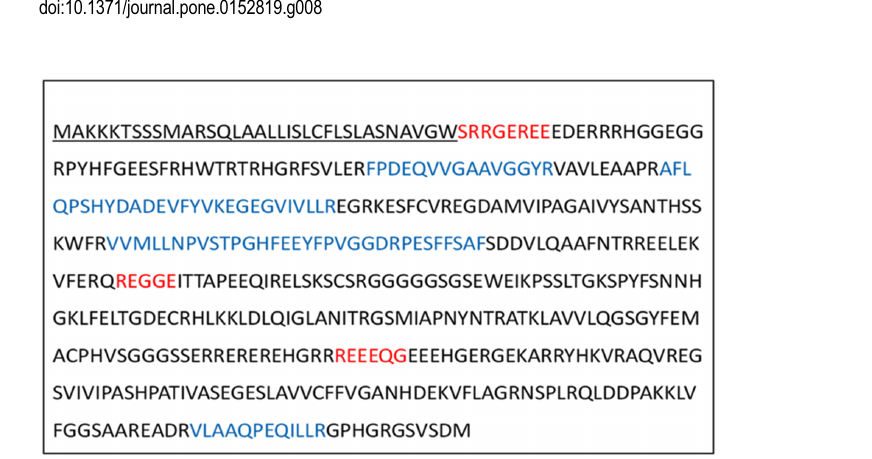
Fig 9. Deduced amino acid sequence of cupincin. The putative signal sequence is underlined (S6 Fig). Amino terminal sequence as determined by Edman degradation method is indicated in red. Peptide sequences obtained by in-gel trypsin digestion and MS/MS analysis are indicated in blue (S8A – S8G Figs). OsI_13867 (NCBI) or LOC Os06g43830.1 (TIGR data base, http://rice.plantbiology.msu.edu/) was identified as